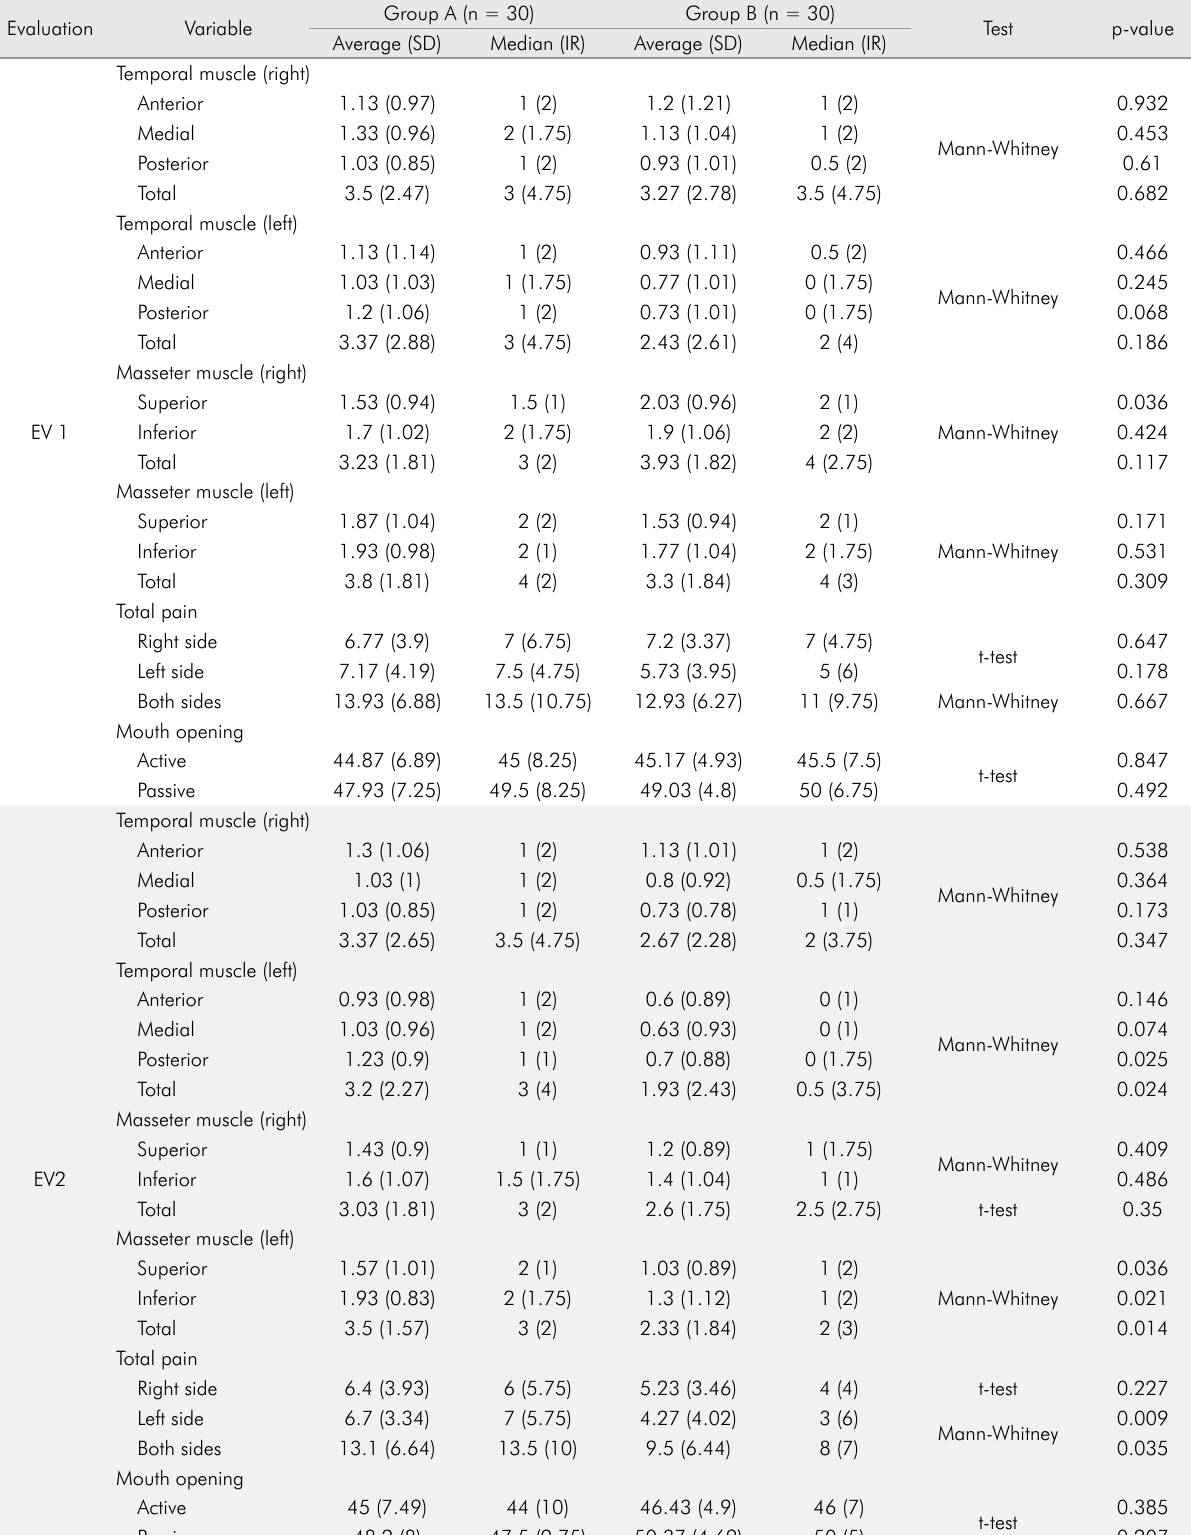
Table 2. Description of pain levels for EV1 and EV2, for both groups (A and B), and multiple comparison tests